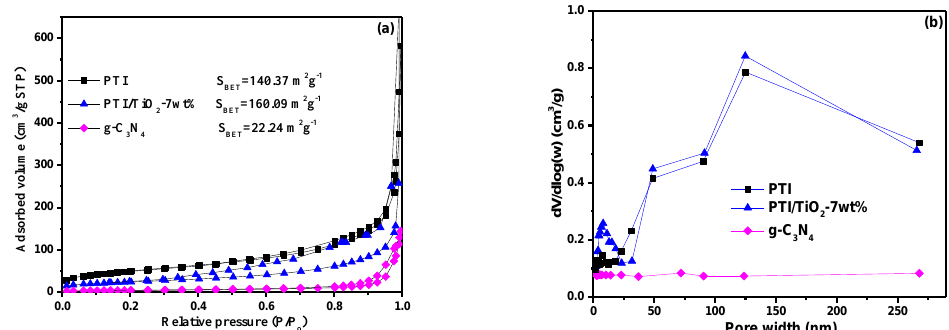
Figure 5. N 2 adsorption/desorption isotherms ( a ) and corresponding pore-size distribution curves ( b ) of as-prepared samples.